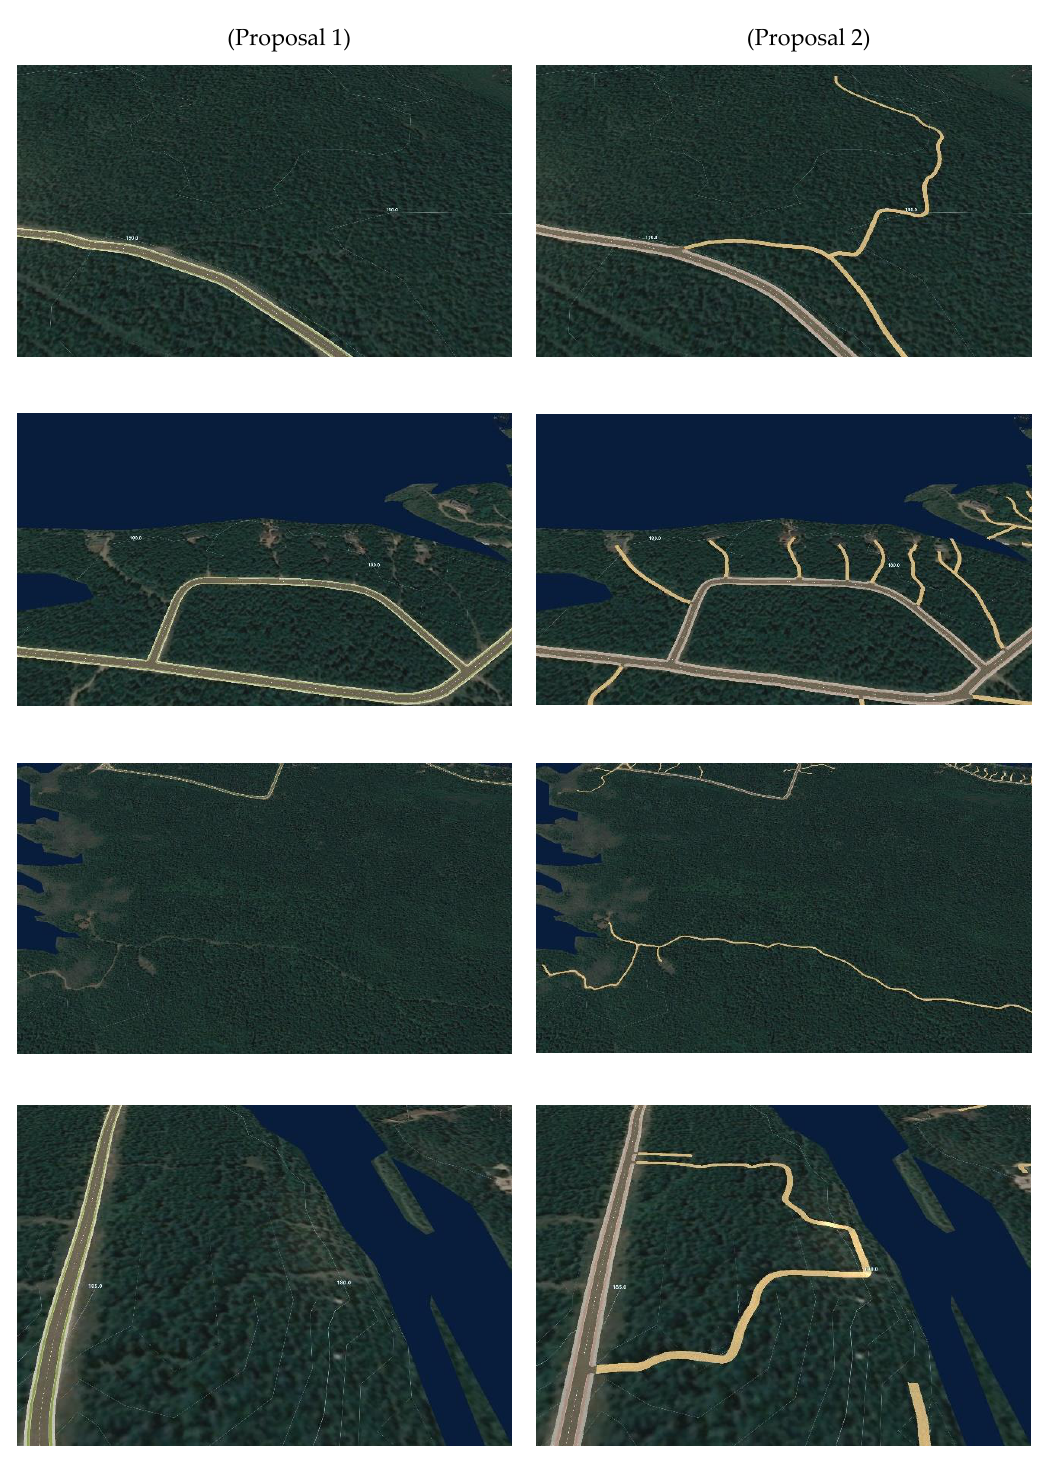
Figure 11. Comparison between Proposal 1 and Proposal 2.